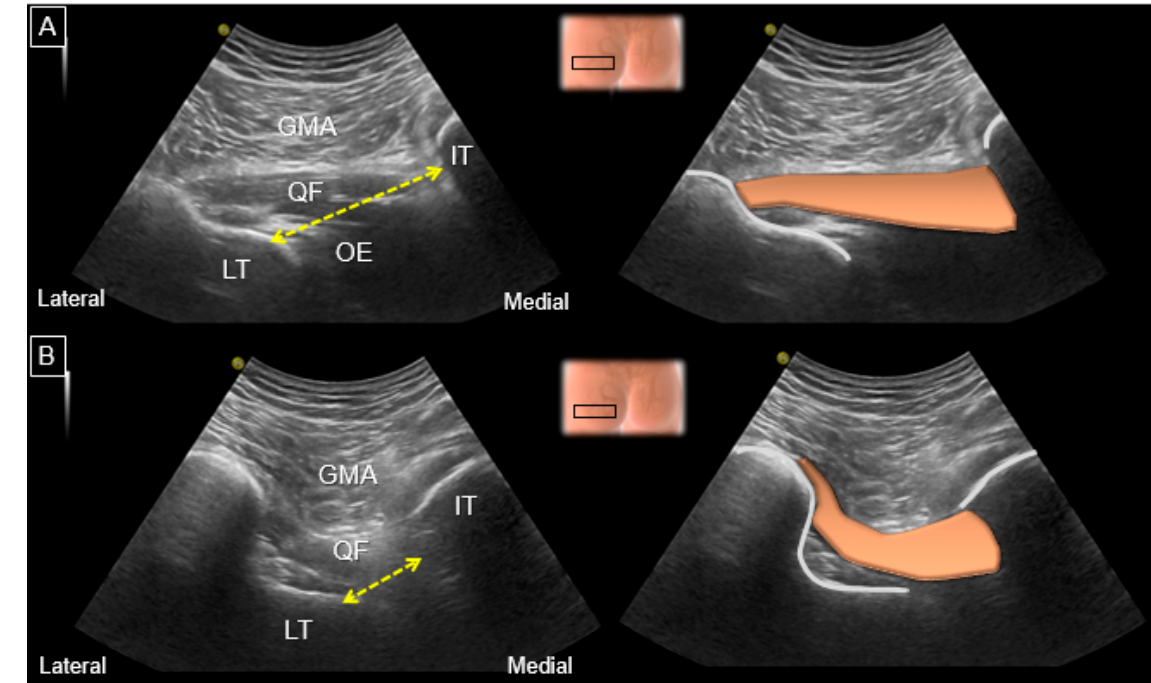
Figure 12. US images and schematic drawings for measuring of the ischiofemoral distance (yellow dashed line) during ( A ) internal and ( B ) external femoral rotations. GMA: gluteus maximus muscle; QF: quadratus femoris muscle, brown color; OE: obturator externus muscle; LT: lesser trochanter; IT: ischial tuberosity.